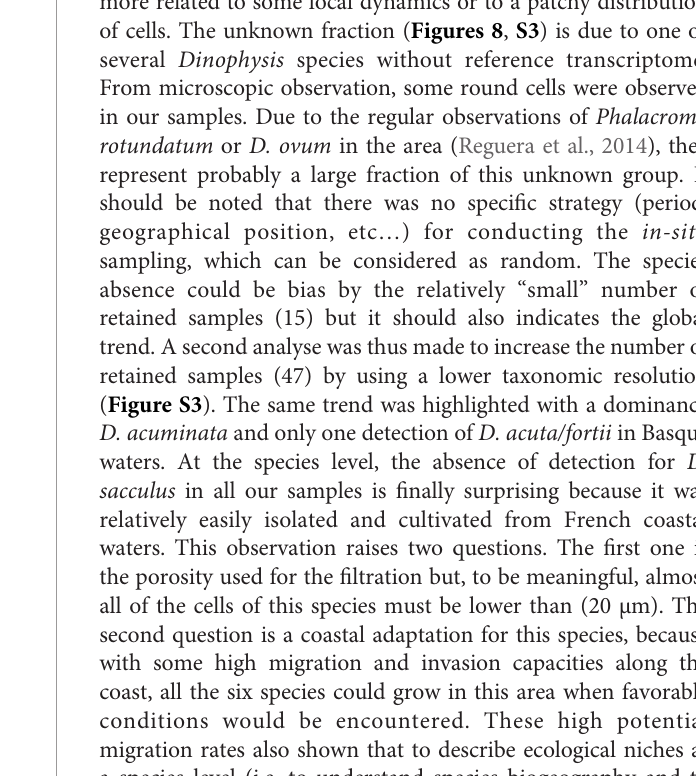
FIGURE 8 | Relative proportion of Dinophysis species based on diagnostic SNPs at the species level (7 taxonomic